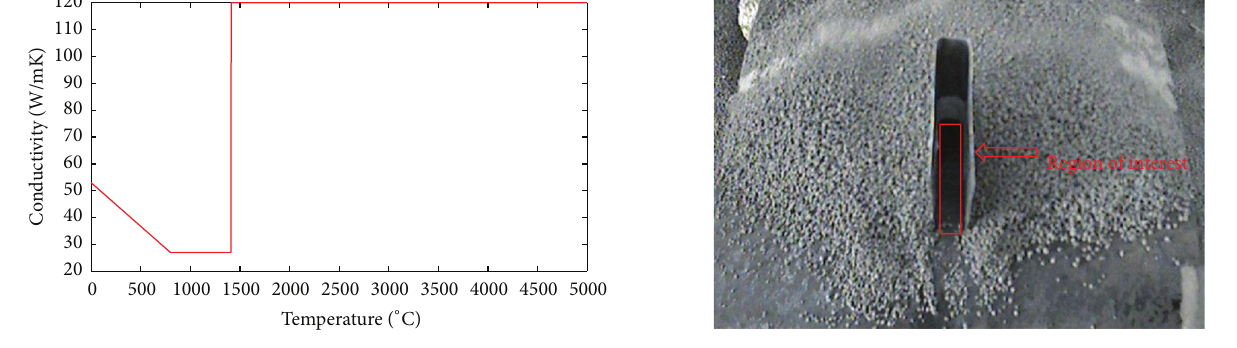
Figure 2: Variation of conductivity with temperature plot.